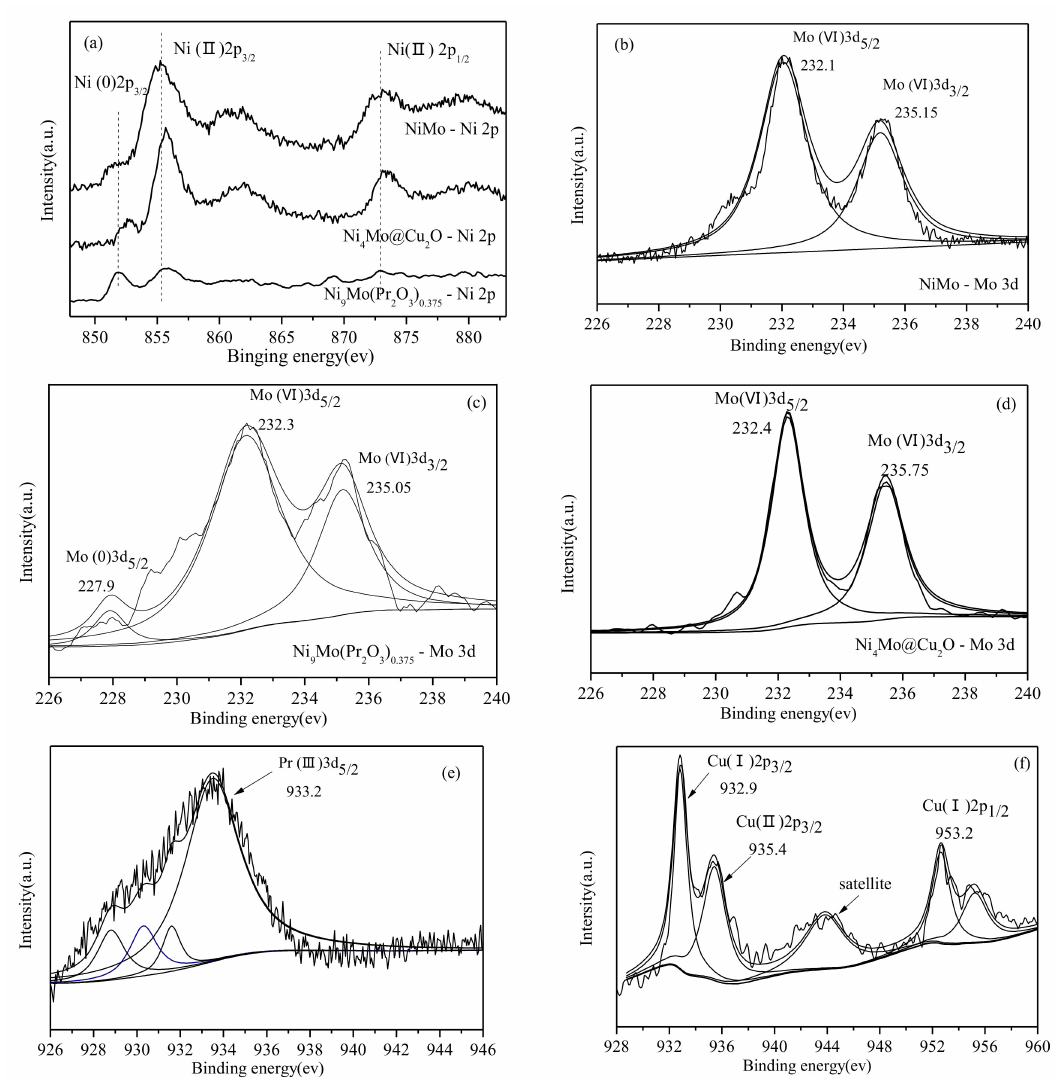
Figure 3. X-ray photoelectron spectra of the as-synthesized Ni 9 Mo 1 , Ni 9 Mo 1 (Pr 2 O 3 ) 0.375 , and Ni 4 Mo@Cu 2 O: ( a ) Ni 2p, ( b ), ( c ), ( d ) Mo 3d, ( e ) Pr 3d, and ( f ) Cu